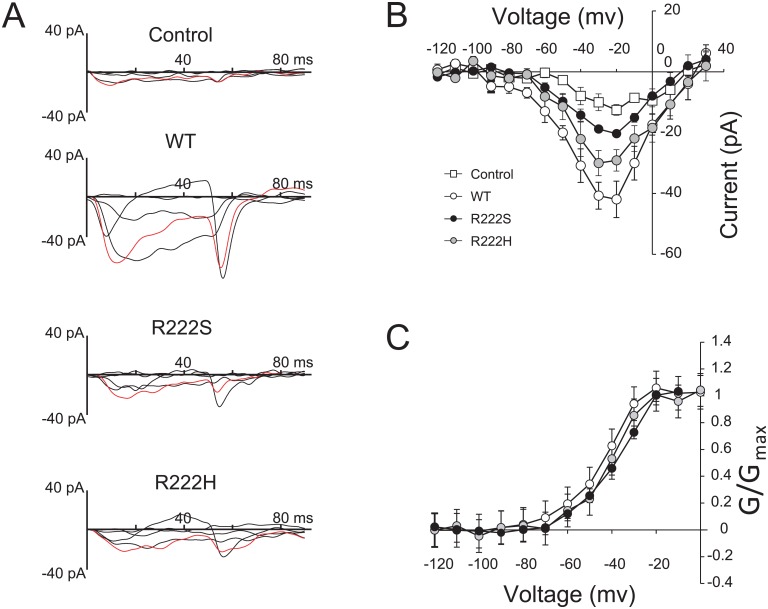
Characteristics of Nav1.9-overexpressing ND7/23 cells.(A) The typical traces of Na+ currents under 3 μM TTX treatment among Nav1.9-overexpressing ND7/23 cells (Control, WT, R222S, and R222H) were selected at step pulses from −80–0 mV for 100 ms with 20-mV increments for clarity. Control indicates ND7/23 cells without Nav1.9 transfection. The data were obtained at 28°C. Red-colored traces were obtained at −20 mV step pulse. (B) Current-voltage relationships for each Nav1.9-overexpressing ND7/23 cell (Control n = 5, WT n = 5, R222S n = 5, and R222H n = 4). Step pulses were applied from −120–30 mV for 100 ms in 10-mV increments. (C) Comparison of activation of each Nav1.9-overexpressing ND7/23 cell. The Boltzmann fit correspond to V1/2 (WT: −44.83 ± 2.44 mV, n = 5, R222S: −39.5 ± 2.09 mV, n = 5, R222H: −42.22 ± 2.91 mV, n = 4).